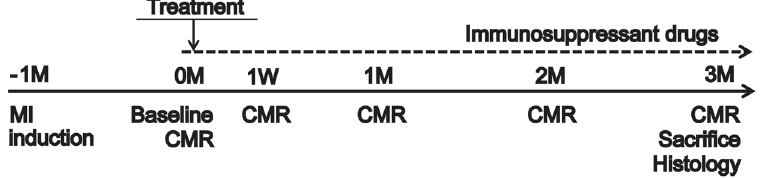
Figure 2. Study protocol of the mini-pig experiments. Schedule of cardiac magnetic resonance imaging (CMR) and histological evaluations.